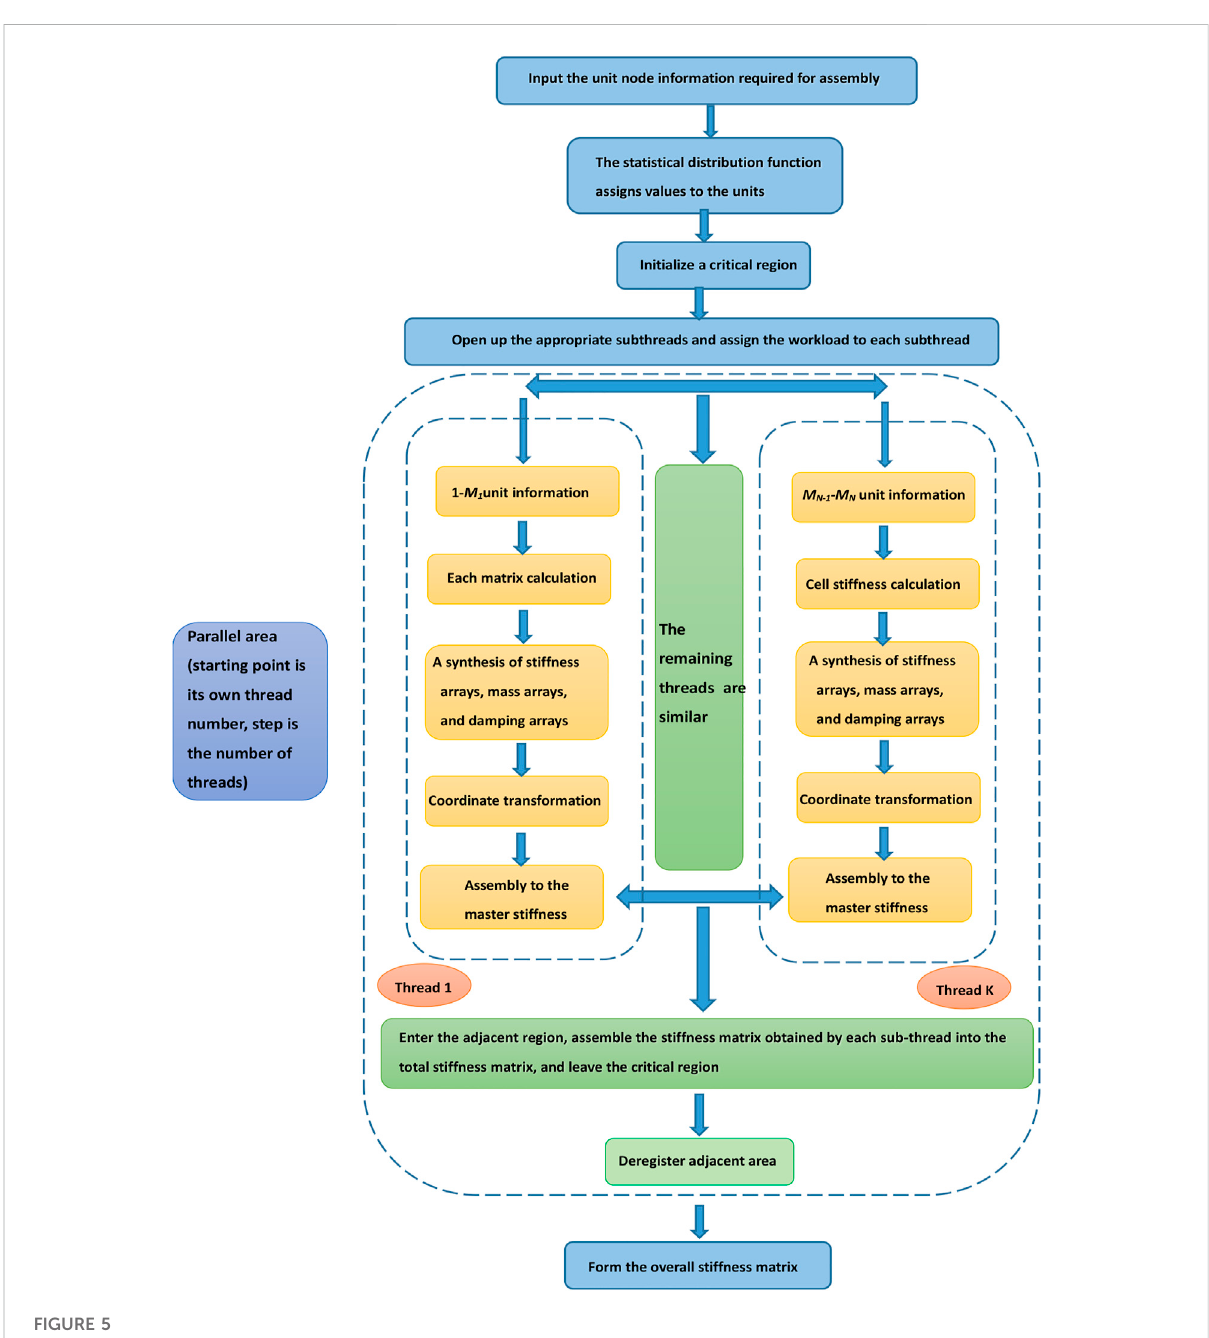
FIGURE 5 Flow chart of the total stiffness